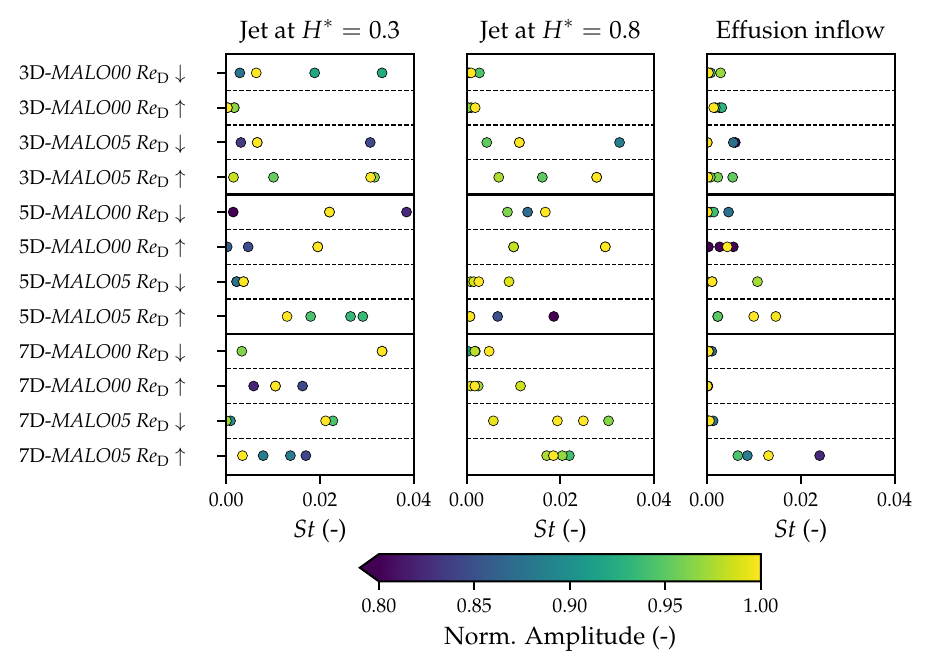
Figure 9. Frequency spectra at different locations for all configurations, using velocity magnitude as data signal. First four dominant frequencies shown. Color scale shows relative